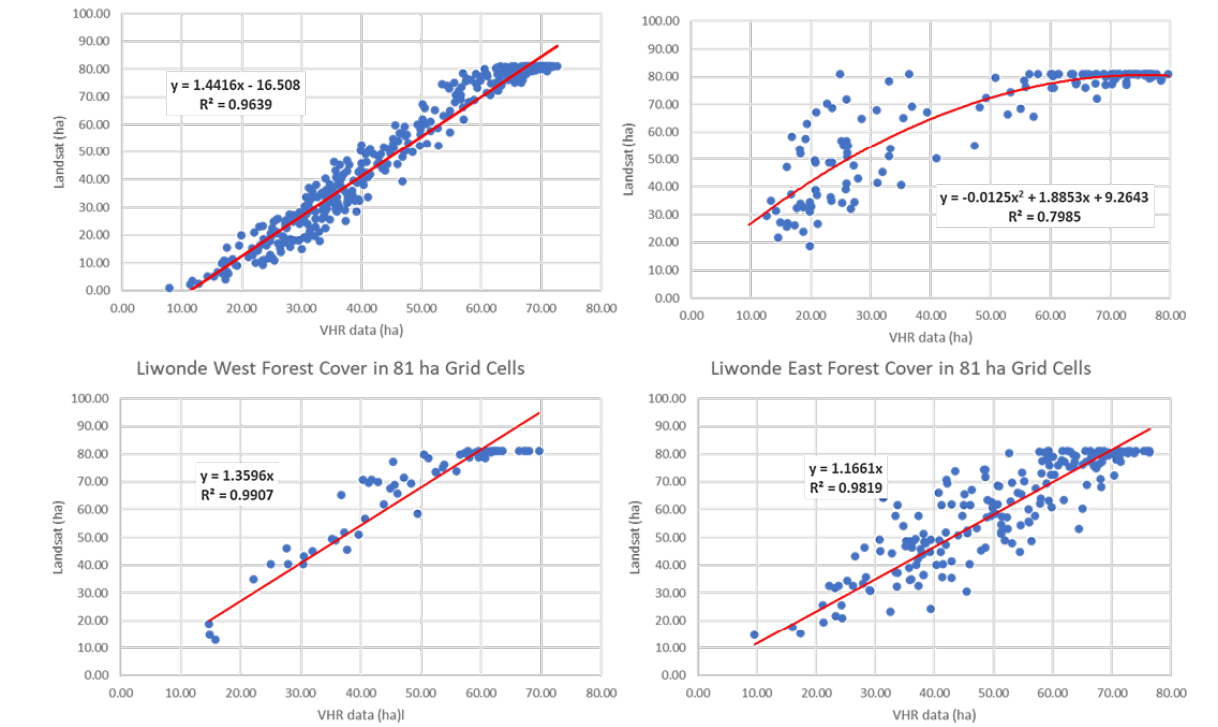
Figure A4. Test site regression analysis to compare the reference forest cover from very high-resolution (VHR) data to the output mapping from the f C Tool. Each data point represents the mapped and estimated forest cover in each 81-hectare grid cell covering the landscape sites shown in Figure A1.